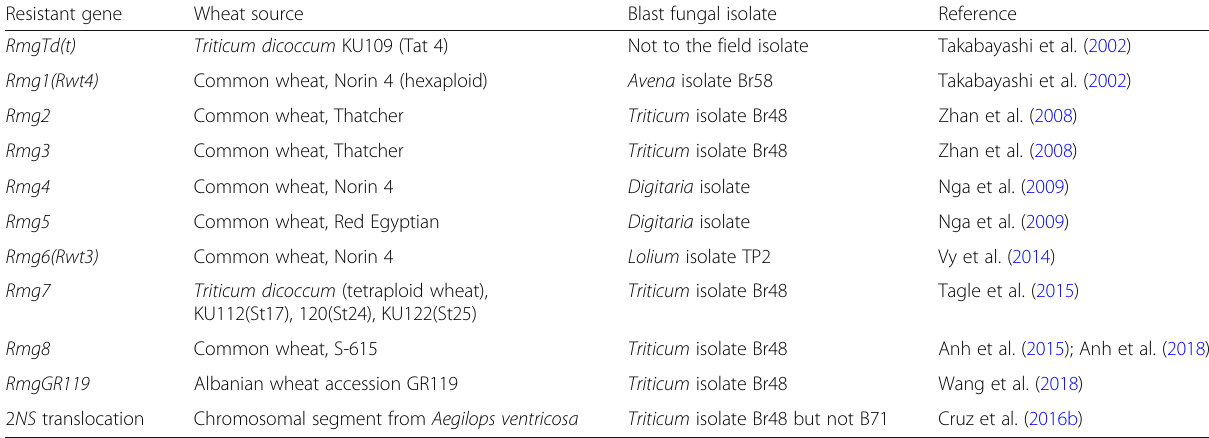
Table 3 Resistant genes discovered in wheat and their roles against blast fungus Resistant gene Wheat source Blast fungal